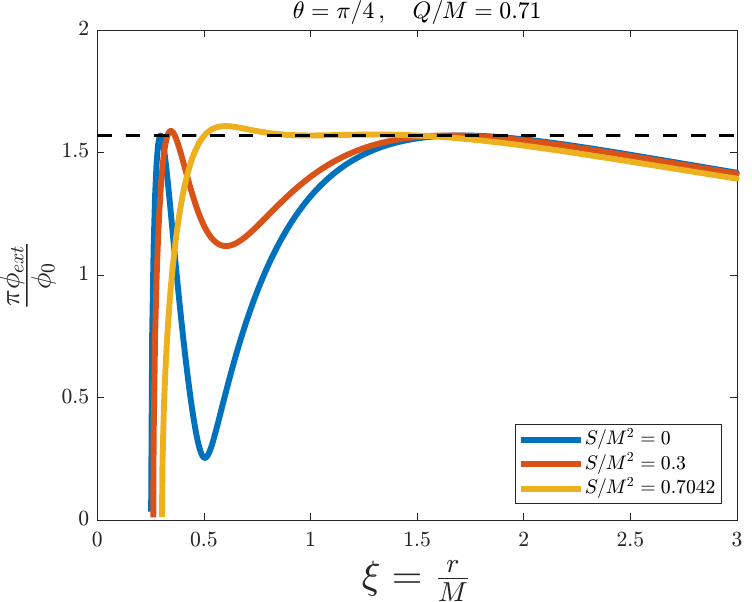
Figure 11. External magnetic flux πφ ext / φ 0 versus the adimensional distance ξ = r / M for the simulation of a Kerr–Newman black hole with fixed θ = π /4 and A = Q / M = 0.71, and for different values of B = S / M 2 . The dashed line represents the threshold value πφ ext / φ 0 = π /2. Figures 12 and 13, with θ = π /2, and B = 0.7 and B = 0.71, respectively, show the same behaviours as Figures 10 and 11, with even bigger non-simulable regions, as the radial size of the ergosphere is maximal at the equator of the black hole ( θ = π